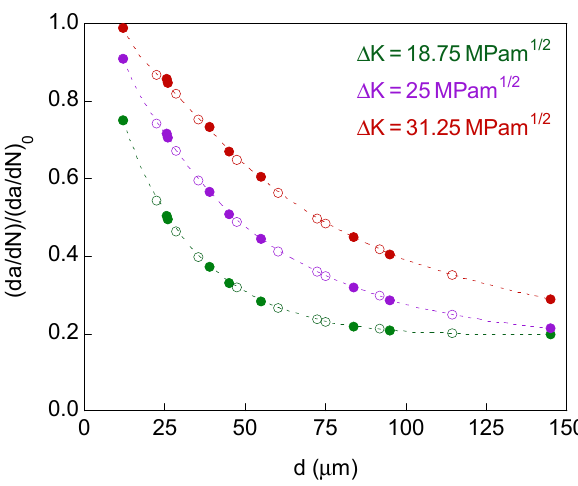
Figure 10. Retardation factor as a function of the distance between crack tips for bifurcated crack tip with the equal initial projected length for the two branches.